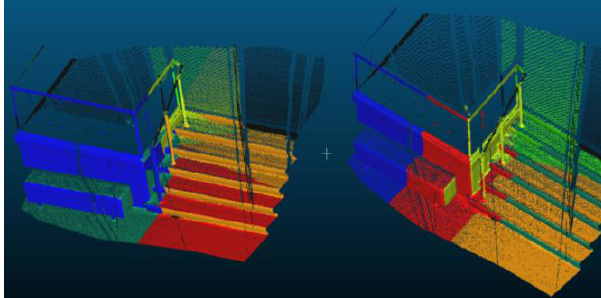
Figure 8: Surface Normal, ANN Segmentation (Left) and K- means Segmentation